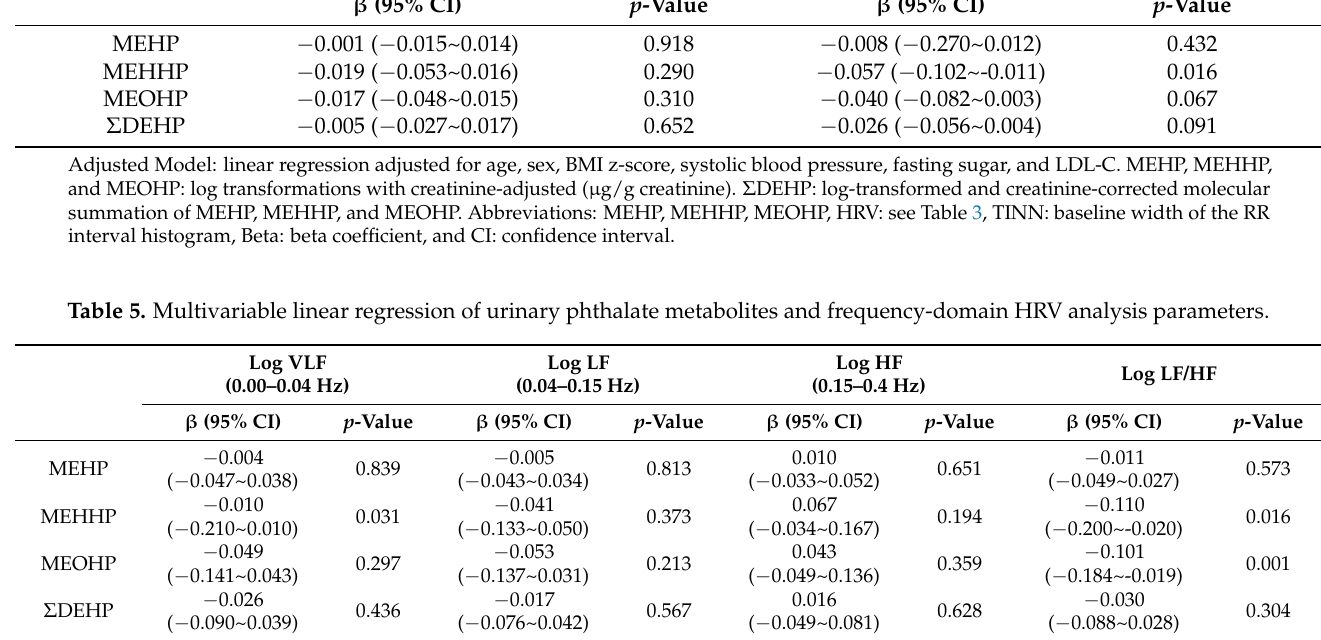
Table 4. Multivariable linear regression of urinary phthalate metabolites and time-domain HRV analysis parameters.